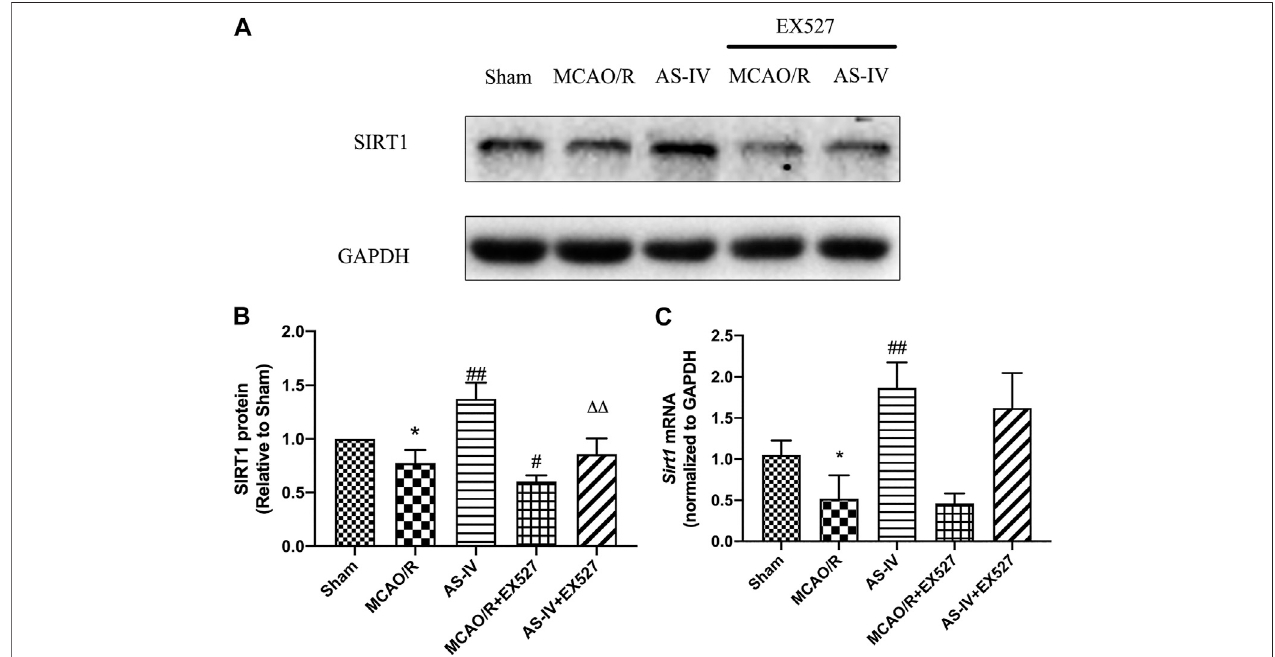
FIGURE8| Theexpression ofSIRT1inSham, MCAO/R, AS-IV, MCAO/R +EX527,andAS-IV +EX527 groupat7daysafter CIRinjury(mean ± SD, n (cid:1) 6). (A) The results from the Western Blot. (B) Quantitative analysis for the protein level of SIRT1. (C) Quantitative analysis for the mRNA level of Sirt1. * p < 0.05, compared with the Sham group; # p < 0.05, ## p < 0.01 compared with the MCAO/R group; ΔΔ p < 0.01 compared with the AS-IV group.